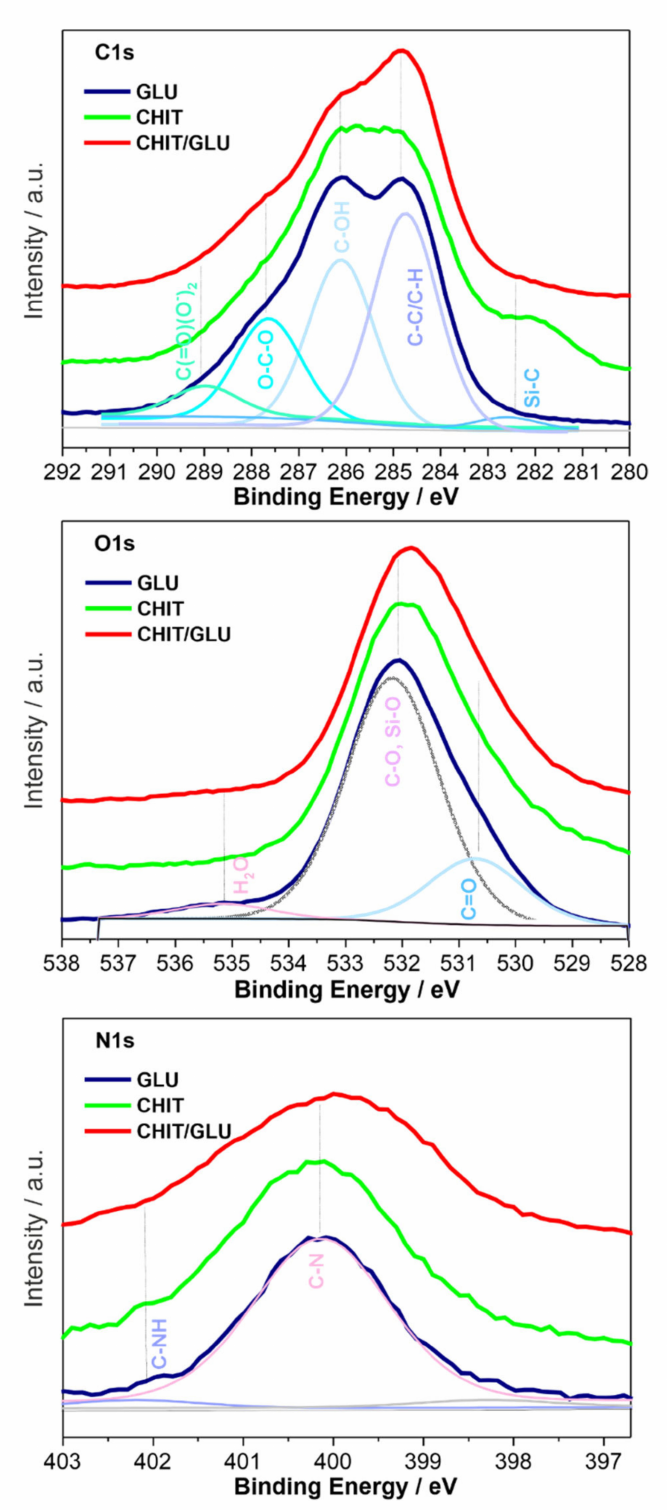
Figure 5. XPS C1s, O1s and N1s core-level spectra for glucan (GLU), chitosan (CHIT) and hybrid chitosan/1,3- β - D -glucan (CHIT/GLU) samples, with peak decomposition and component position and